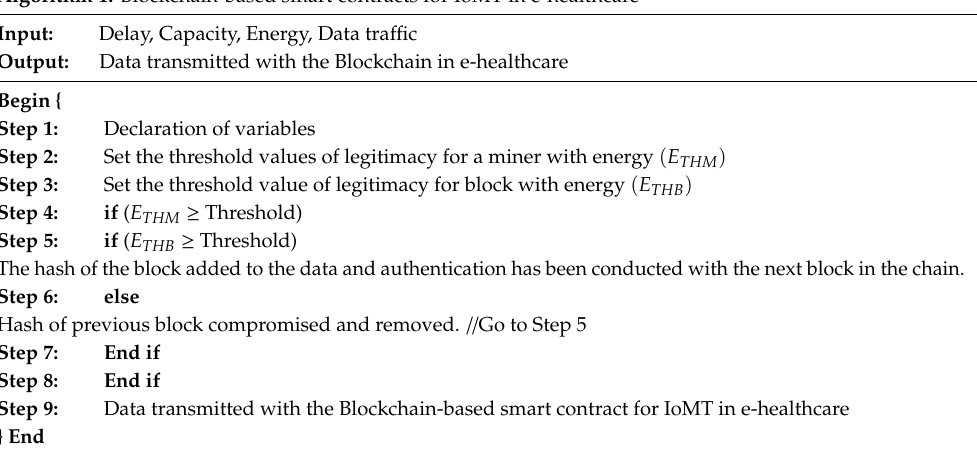
Algorithm 1: Blockchain-based smart contracts for IoMT in